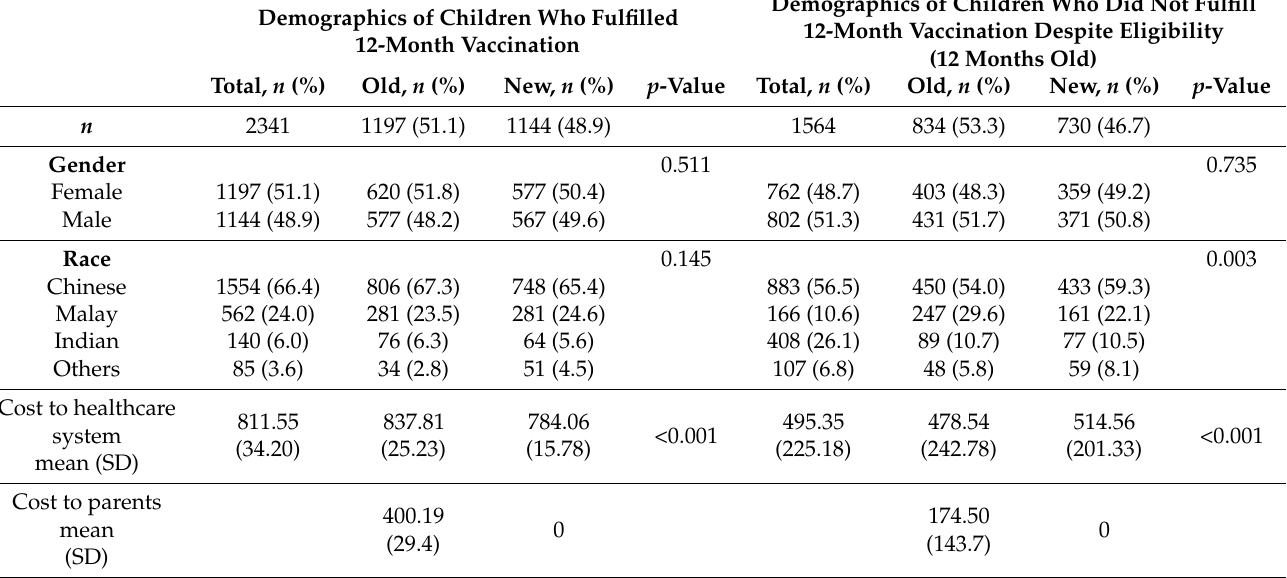
Table 3. Demographics of children who fulfilled and did not fulfill 12-month vaccination uptake requirements according to the national childhood immunization